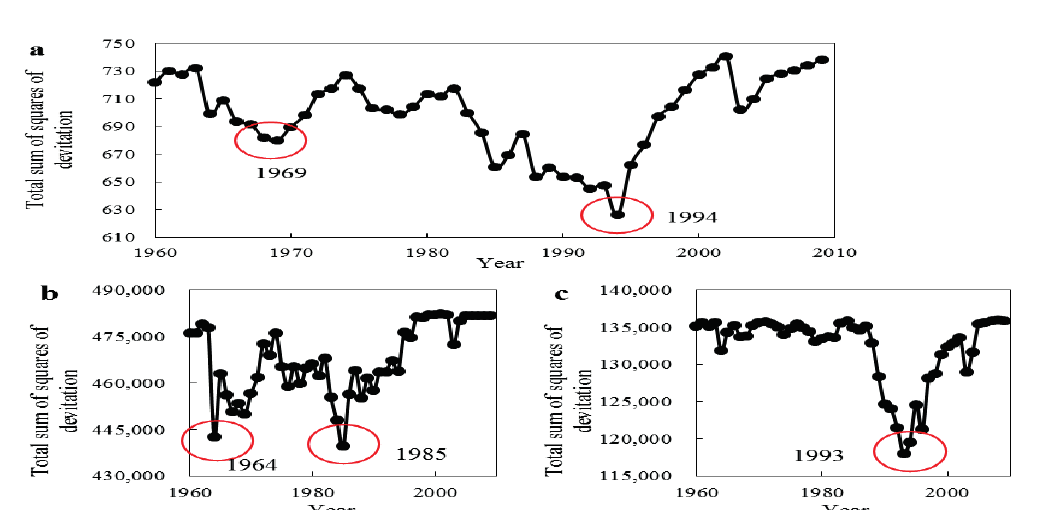
Fig. 2 The change points in the Beiluohe River basin: (a) runoff, (b) precipitation, and (c) PE.